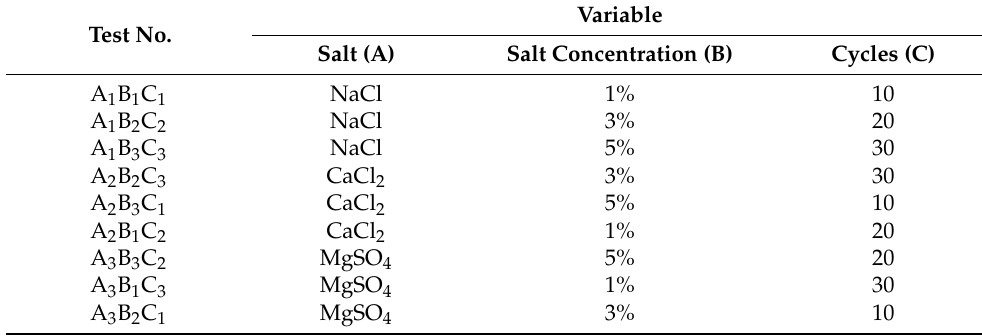
Table 3. Factors and levels of orthogonal test.